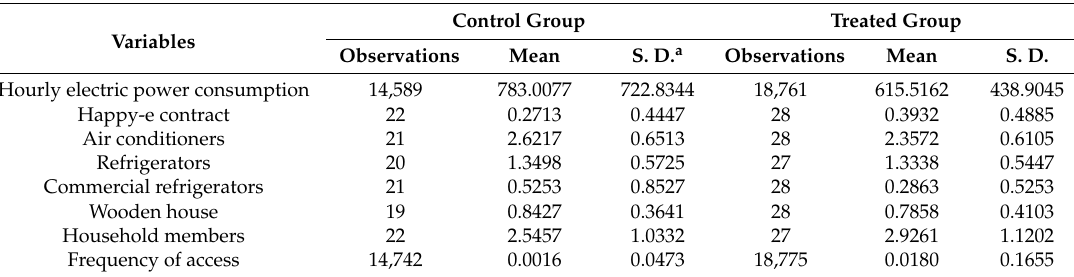
Table 2. Descriptive statistics of experimental data.